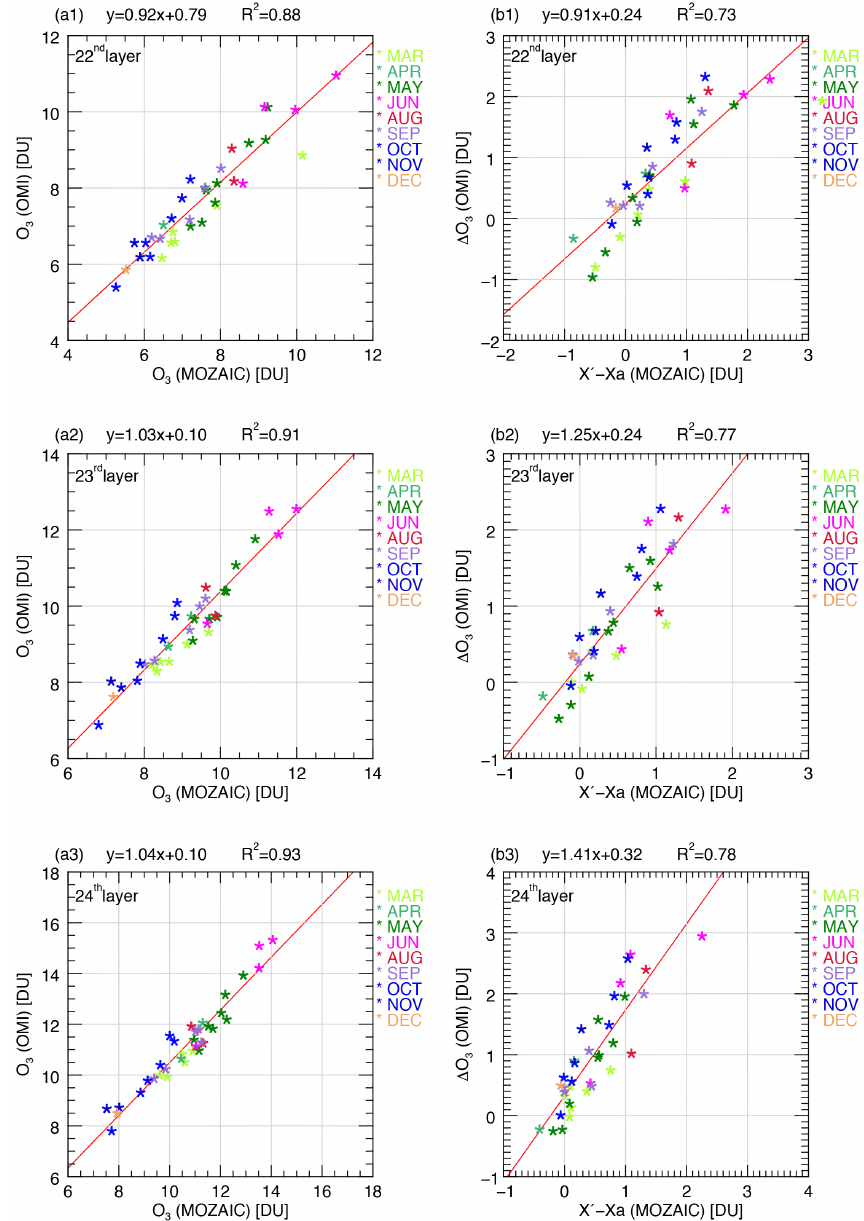
Figure 5. Same as Fig. 3a1–b3 except that MOZAIC values are convolved with OMI AKs (rows) according to Eq. (1).